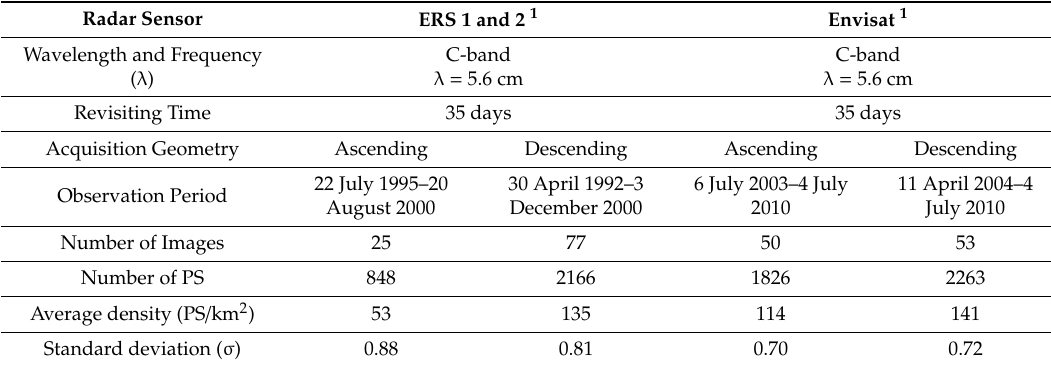
Table 1. Details of collected Interferometric Synthetic Aperture Radar (InSAR) data provided as a set of Persistent Scatterers (PS).